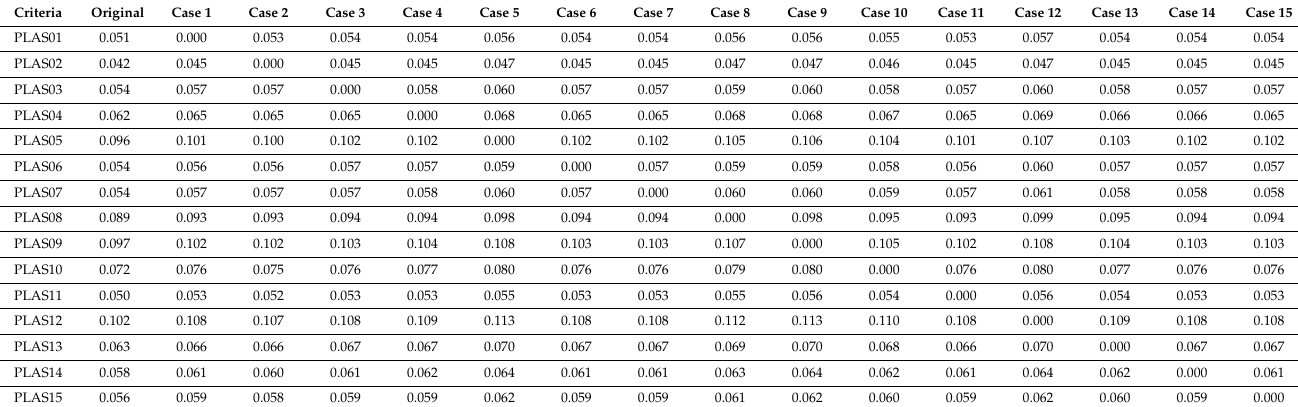
Table 6. Criteria weights in all cases.